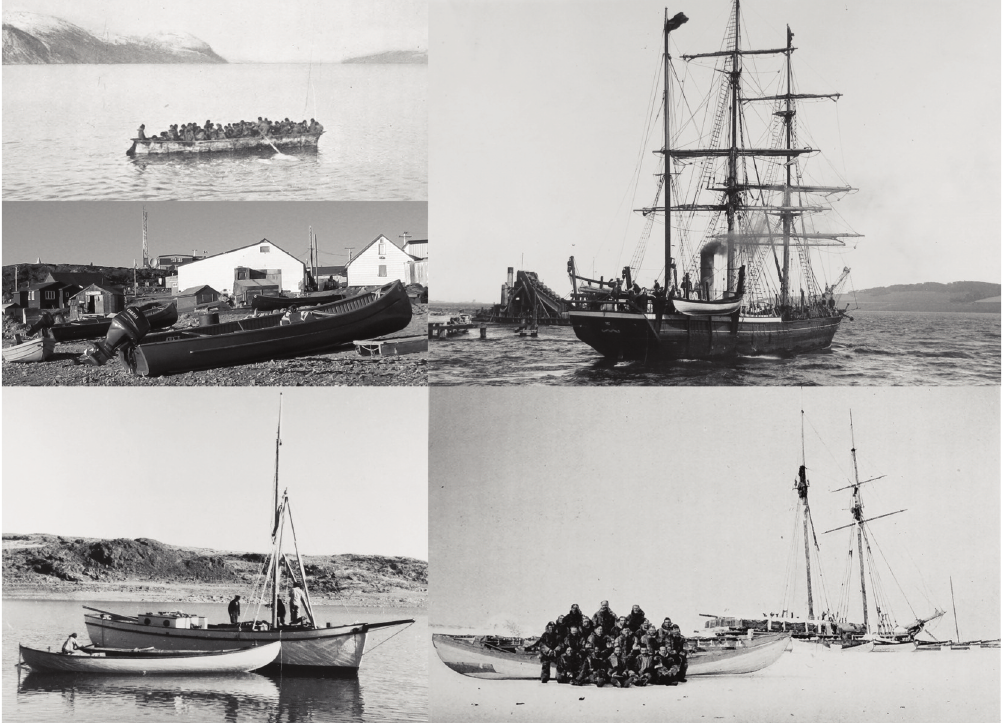
Fig. 6. Various craft have been used to hunt walruses in the eastern Canadian Arctic and have had their catches described as a “boatload” (proceeding clockwise from upper left): upper left) an umiak at Wakeham Bay in 1903 (Low 1906:facing 64) was made of hide (possibly wal- rus) and used for transport but in the past umiaks were also used to hunt walruses (Bruemmer 1992); upper right) the Scottish steam whaler Active leaving Dundee for Baffin Island took many walruses between 1898 and 1913 (HBC Archives photo 1987/363-W-46/26); lower right) the New Bedford whaling schooner Era , wintering at Cape Fullerton in the spring 1904 with a whaleboat in the foreground, also caught walruses (Low 1906:facing 250); lower left) the Peterhead boat Seal and a whaleboat carrying a kayak at Fort Ross in July 1949 (credit L.A. Learmouth, HBC Archives photo 1987/363-E-396/26); and middle left) a modern canoe with an outboard motor at Cape Dorset (credit: D.B.